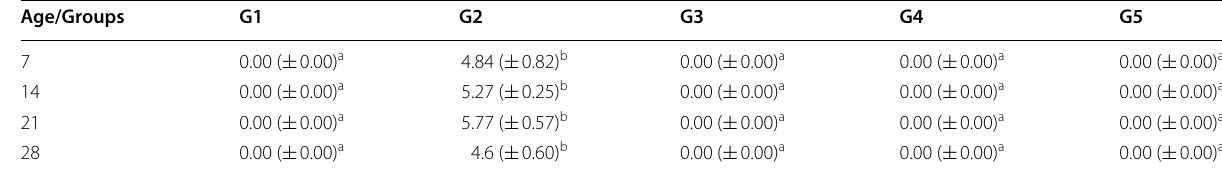
Values represent mean and standard deviation. G1: group inoculated with phage M13. G2: Group inoculated with E. coli ER2738 infected by the phage M13; G3: Group infected with E. coli ER2738; G4: Group inoculated with PEG; G5: Group inoculated with PBS. The birds of G1 were inoculated at all ages (10 PFUs/bird). The birds of G3 were inoculated at 2 days (5.04 log CFU/animal), 8 days (6.64 log CFU/animal) and 15 days of age (6.69 log CFU/animal). Different letters represent statistical difference (P > 0.05) by grouped